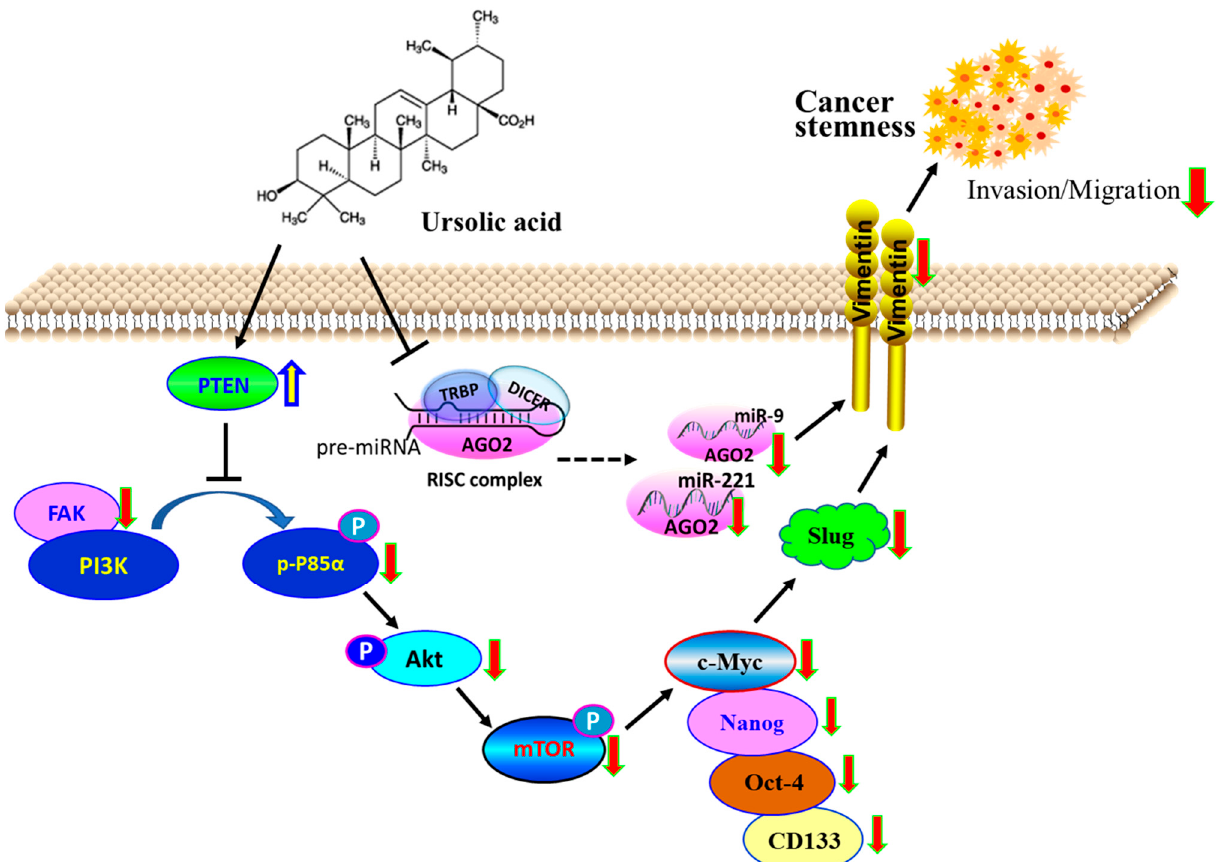
Figure 5. Schematic representation of anticancer activity through decreased BCSC. Tumor suppressive role of PTEN, whose gain in responding to UA decreases the fraction of CSC by downregulating the expression of AGO2 to inactivate the FAK/PI3K/Akt/mTOR and c-Myc signaling pathway. The model also suggests that UA decreased the AGO2-mediated biogenesis of miR-9 and -221 that contribute to the reduction in slug and vimentin, leading to the inhibition of breast cancer invasion and migration during